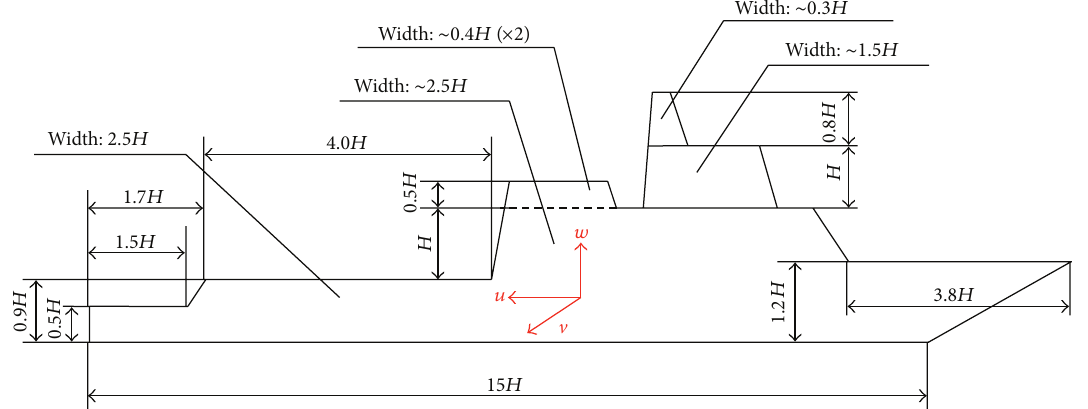
Figure 14: Sketch of the ship model.